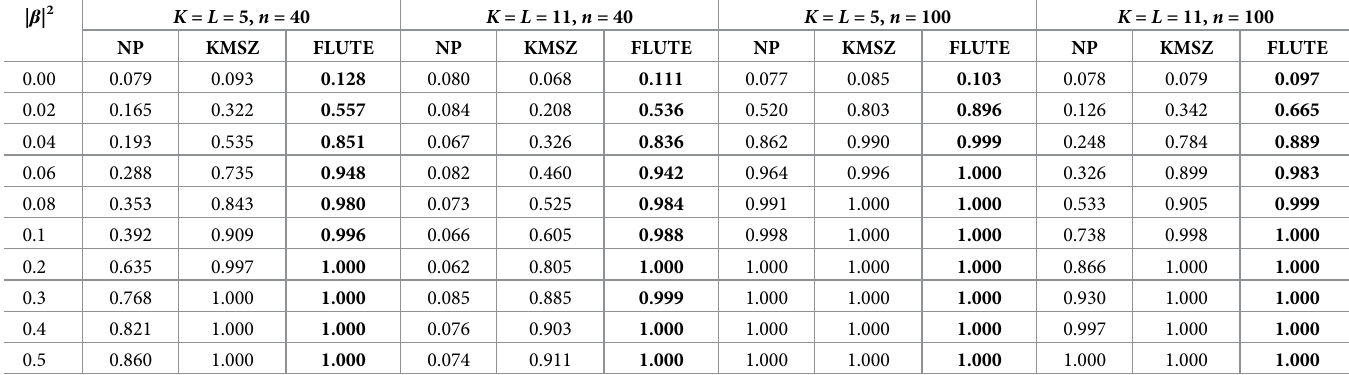
Table 3. Size and power for different tests at α = 0.1.